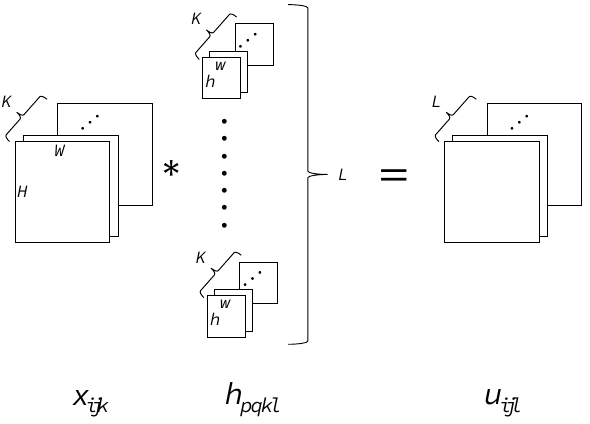
Figure 2. Schematic of the calculation performed in the convolutional layer.